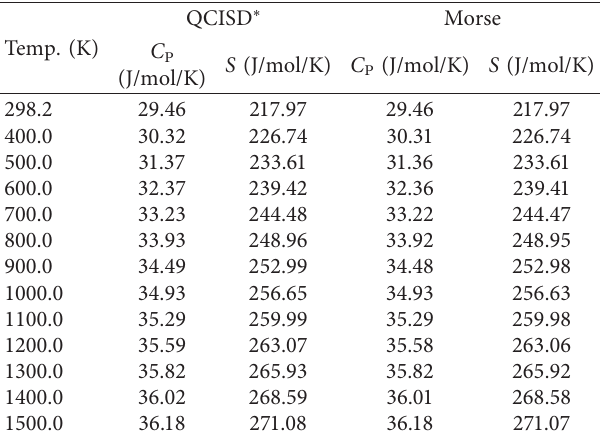
Table 4: Entropy and heat capacity of